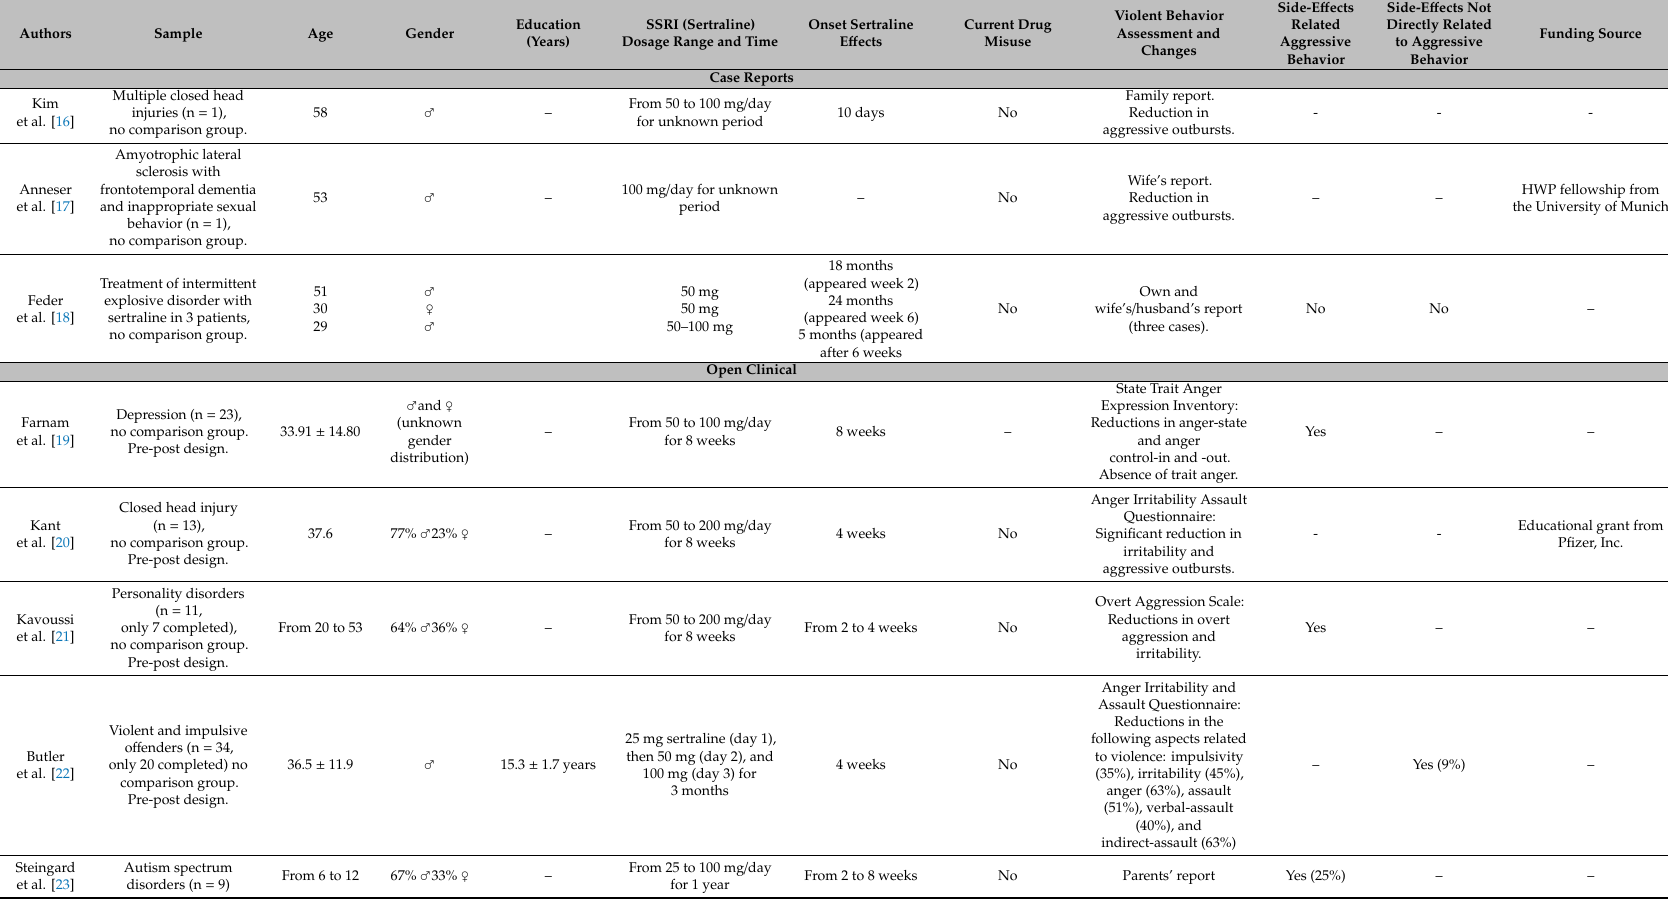
Table 1. Main socio-demographic characteristics and details about the participants in each study and the assessment methods